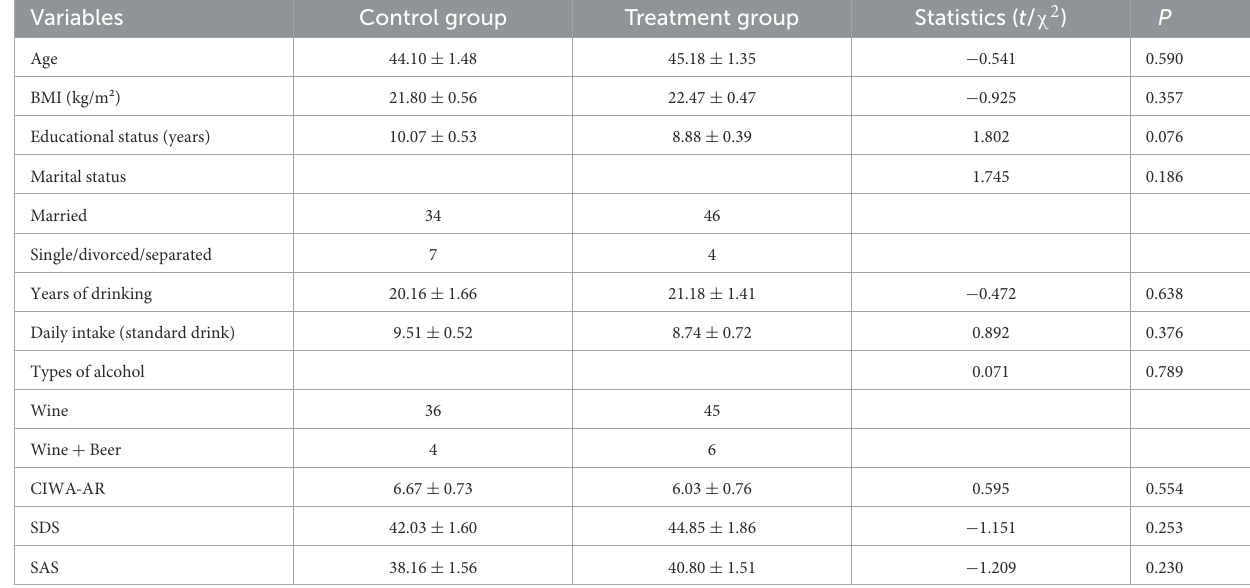
TABLE 1 Comparison of demographic and clinical data in the treatment and control groups (mean ±